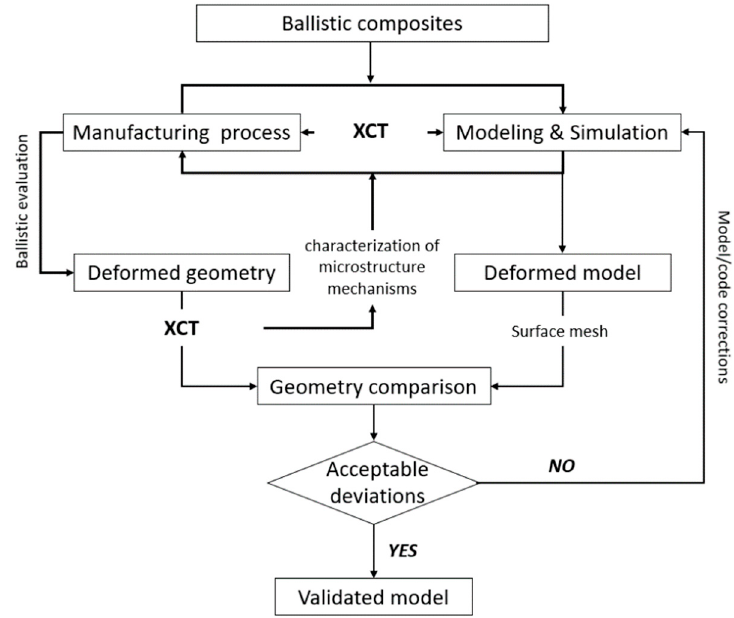
Figure 21. XCT approach to ballistic composite development.